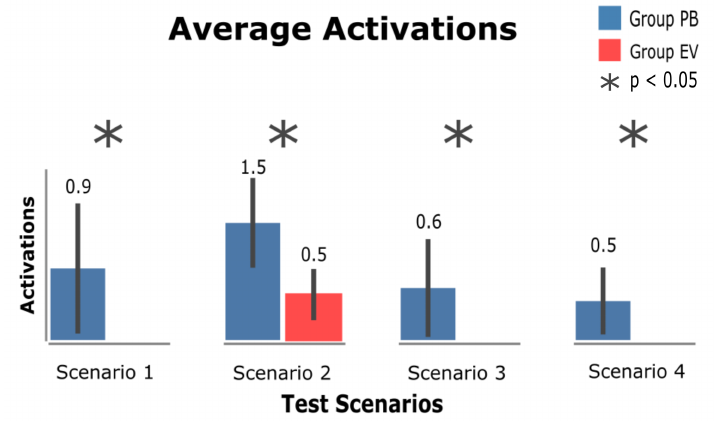
Figure 18. Number of BP and eViacam component activations.